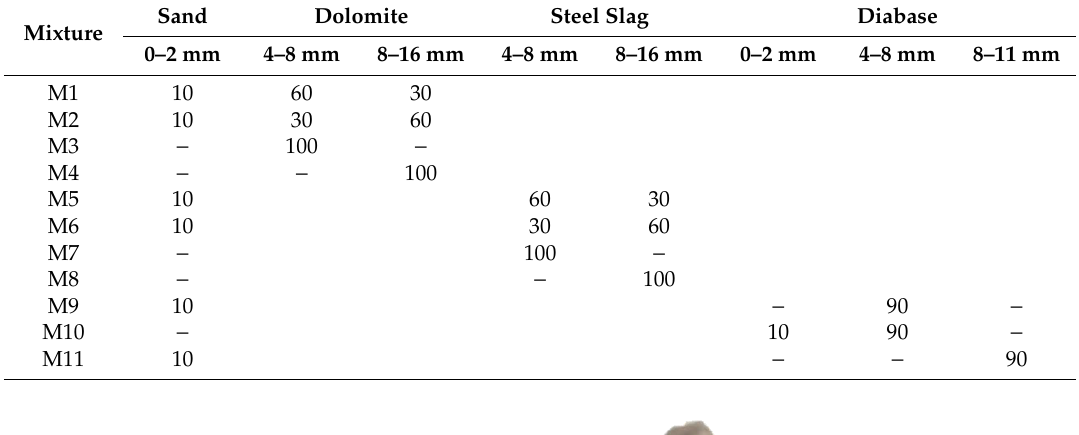
Table 1. Pervious concrete mixture composition—fraction share in %.